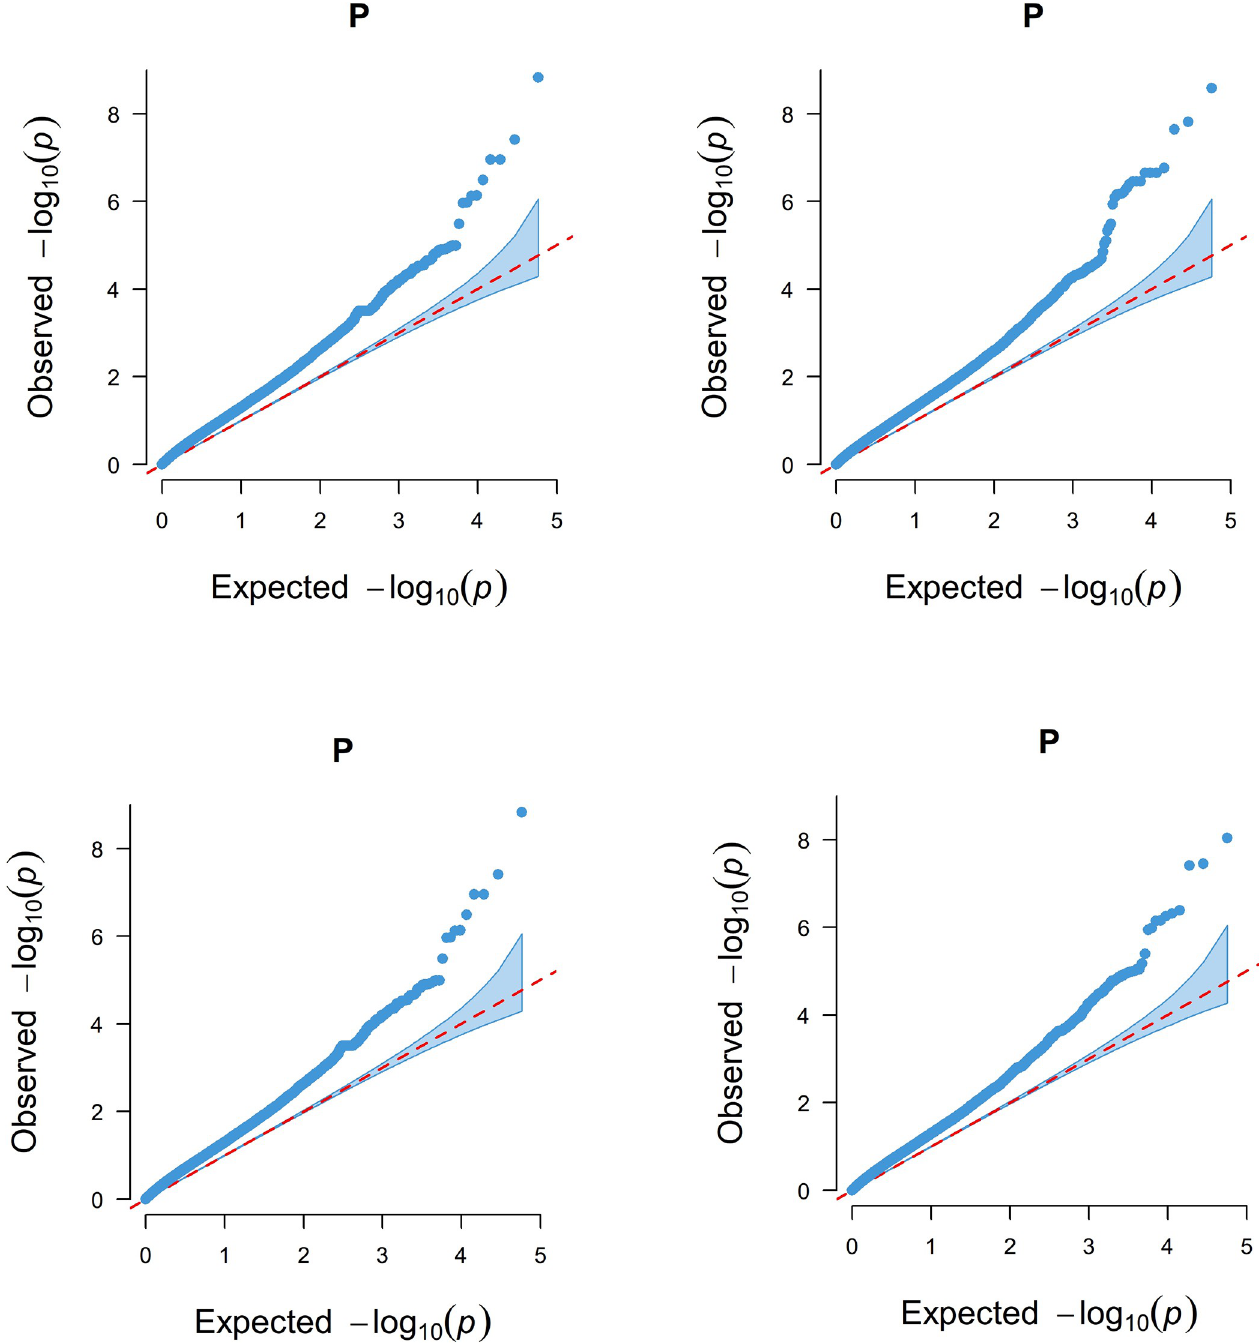
Fig 4. Quantile-quantile (Q-Q) plots of Genome-wide association results for 4 traits. Note: A for Body length; B for Body height; C for Body weight; D for the chest circumference. https://doi.org/10.1371/journal.pone.0283383.g004 Zhang et al . [5] had obtained 36 significant SNPs for seven traits, while we obtained 55 sig- nificant SNPs for 4 traits (body weight, body height, body length, and chest circumference), which enriched the SNPs related to sheep growth and development. Furthermore, Jiang et al .